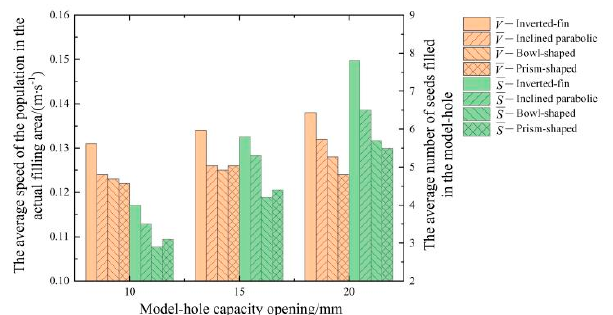
Figure 17. Effect of model-hole capacity opening on the average speed of the population and the average number of grains filled in the actual seed filling area.